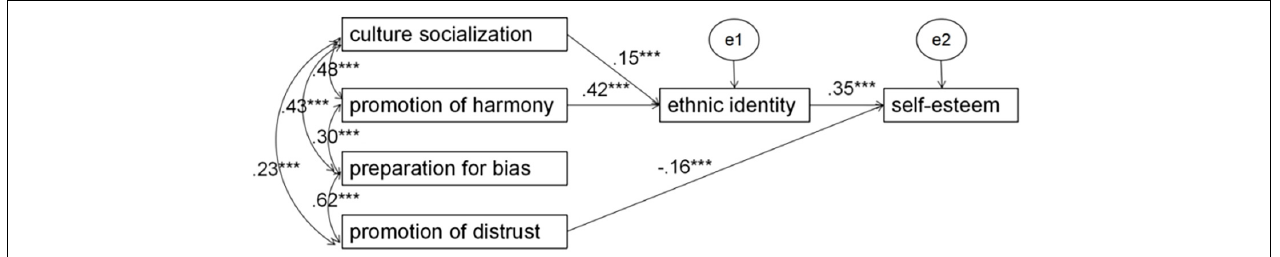
FIGURE 1 | Structural equation model: χ 2 (df6) = 17.59; CMN/DF = 2.93; GFI = 0.99; CFI = 0.98; RMSEA = 0.06. *** p < 0.001. All paths are significant.